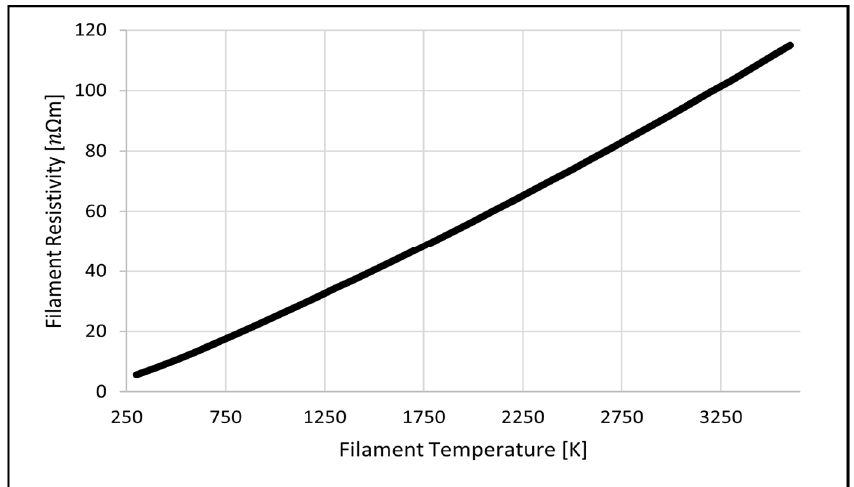
Figure 2. Temperature dependence of tungsten resistivity.